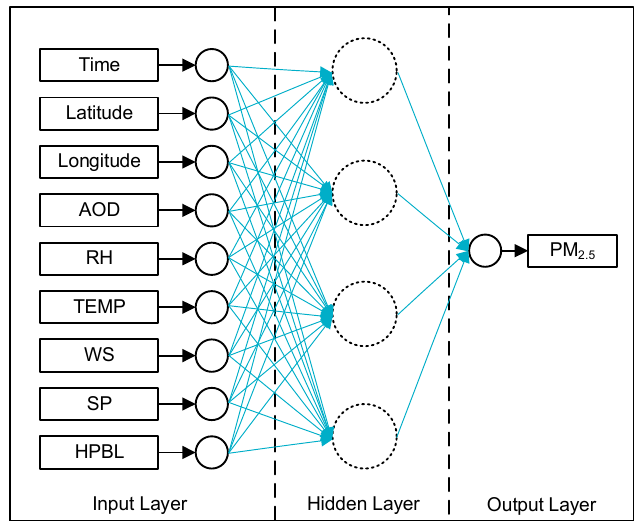
Figure 1. The structure of neural network model.